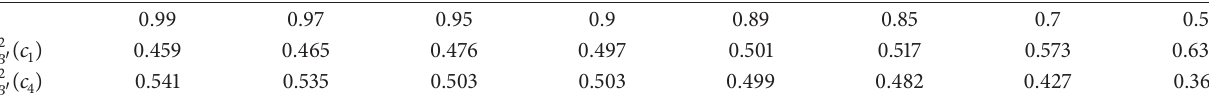
Table 3: The relation of the value of 𝛼 and voting